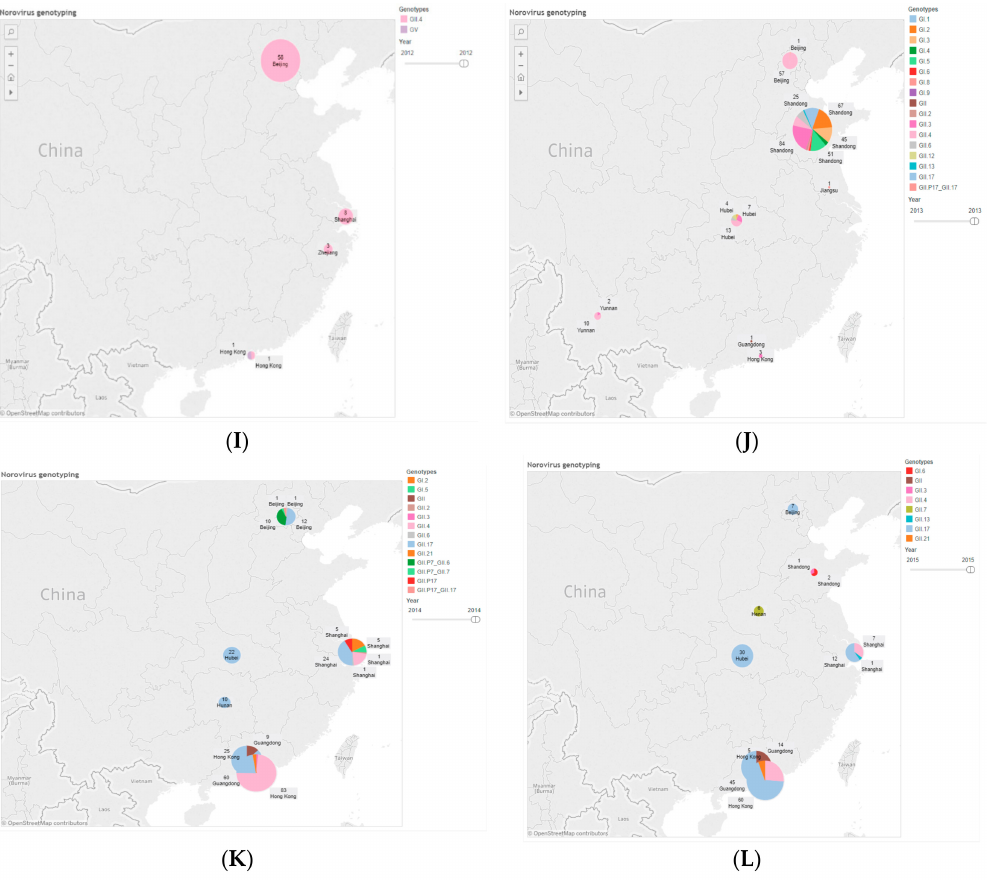
Figure 6. Genotyping distribution in each year according to 1291 VP1 sequences of norovirus in China during 2004 to 2015. The pie in the figures were generated by the number of genotypes ( n = 1291). ( A ) Genotyping distribution in 2004. ( B ) Genotyping distribution in 2005. ( C ) Genotyping distribution in 2006. ( D ) Genotyping distribution in 2007. ( E ) Genotyping distribution in 2008. ( F ) Genotyping distribution in 2009. ( G ) Genotyping distribution in 2010. ( H ) Genotyping distribution in 2011. ( I ) Genotyping distribution in 2012. ( J ) Genotyping distribution in 2013. ( K ) Genotyping distribution in 2014. ( L ) Genotyping distribution in